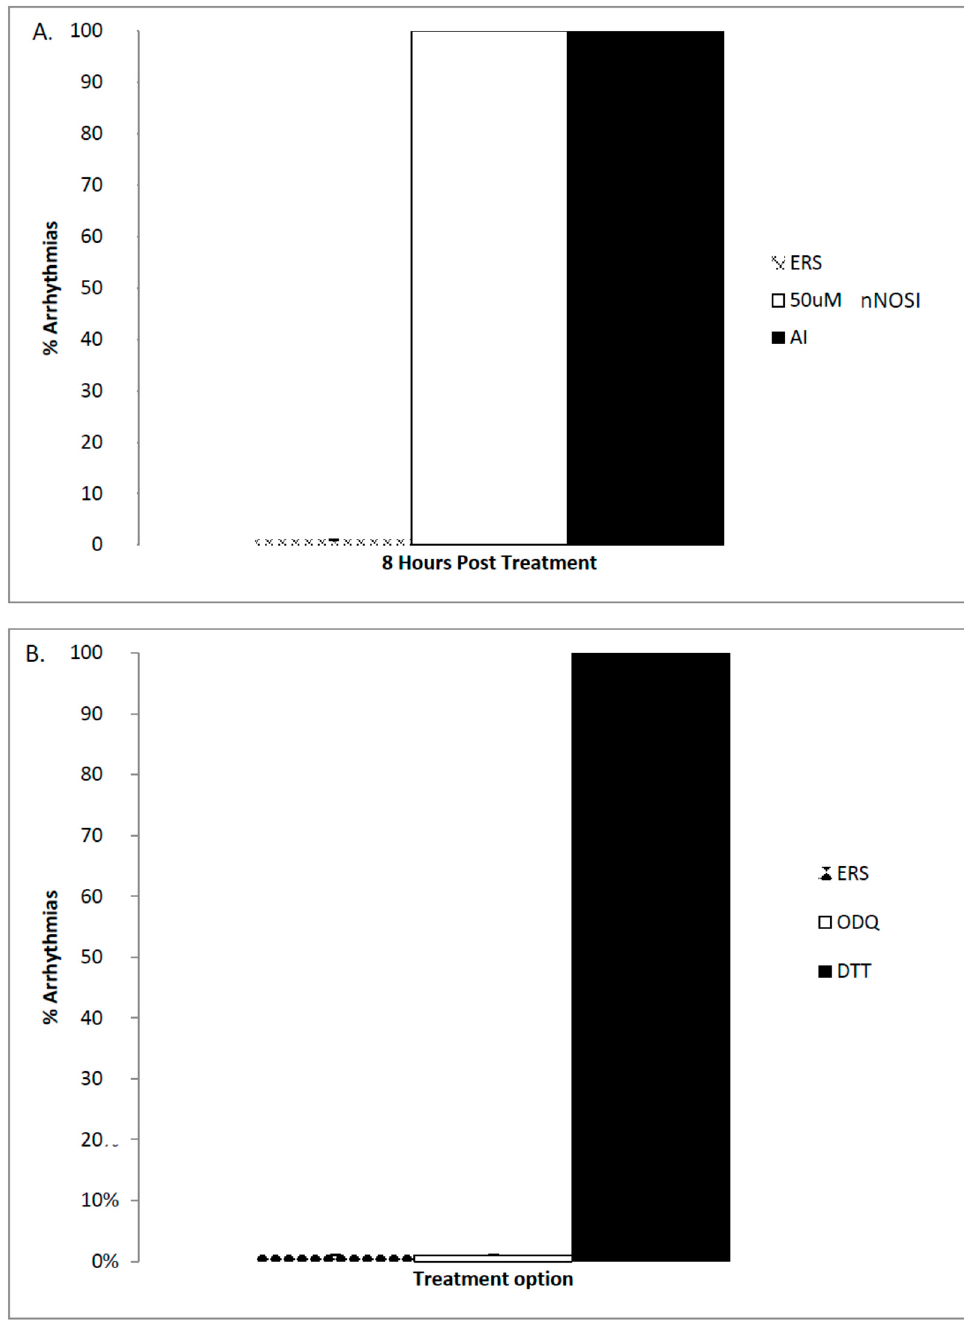
Figure 4. An analysis of arrhythmic behavior under various treatment conditions in the embryonic zebrafish. ( A ) Both AI (50 µ M) and nNOSI (50 µ M) fish treated at 6 dpf and analyzed 8 h later caused 100% of the population to exhibit the arrhythmic phenotype; ( B ) The demonstration that the arrhythmic phenotype can be attributed to the NO/sGC/cGMP-independent pathway inhibition in fish treated at 6 dpf and analyzed 8 h later. Specifically, fish treated with 100 µ M DTT, which reverses S-nitrosylation protein modification, elicits the arrhythmic phenotype in 100% of the fish population. In contrast, no arrhythmic phenotypic expression is evident with a 50 µ M ODQ (1H-[1–3]oxadiazolo[4,3-a]quinoxalin-1-one) treatment, which blocks the activity of sGC, and is no different than that of the ERS controls ( p > 0.05).